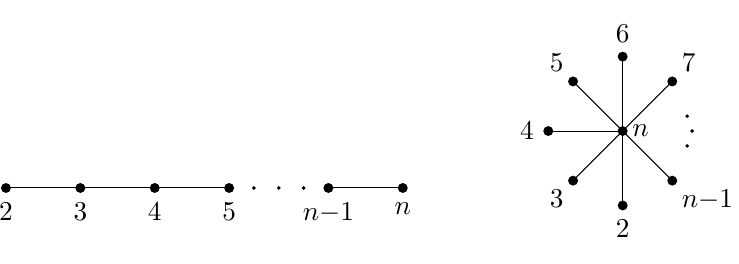
Figure 3. Two examples of Cayley graphs, C H and C S